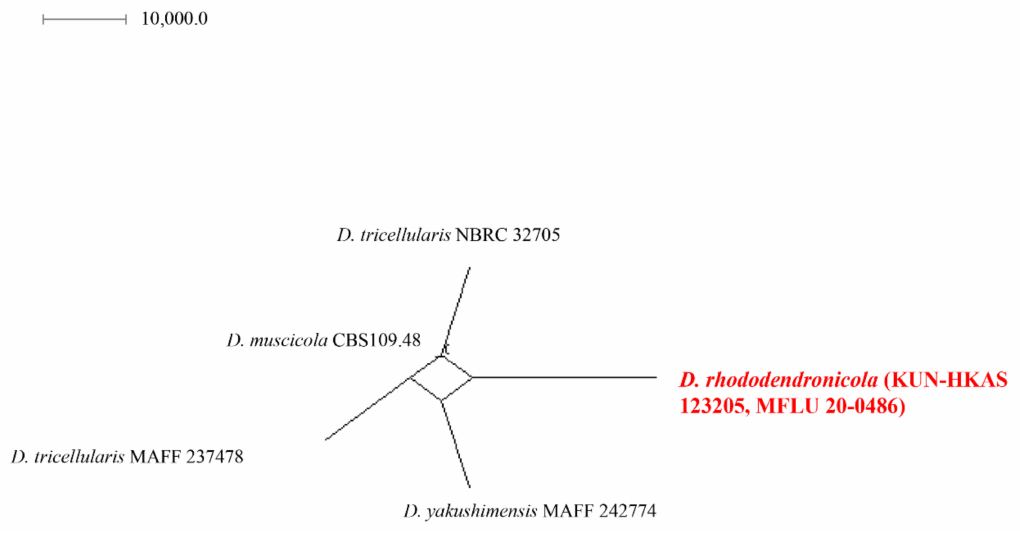
Figure 5. Results of the pairwise homoplasy index (PHI) test of closely related species using both LogDet transformation and splits decomposition. PHI test results ( Φ w) <0.05 indicate significant recombination within the dataset. The new taxon is in red bold